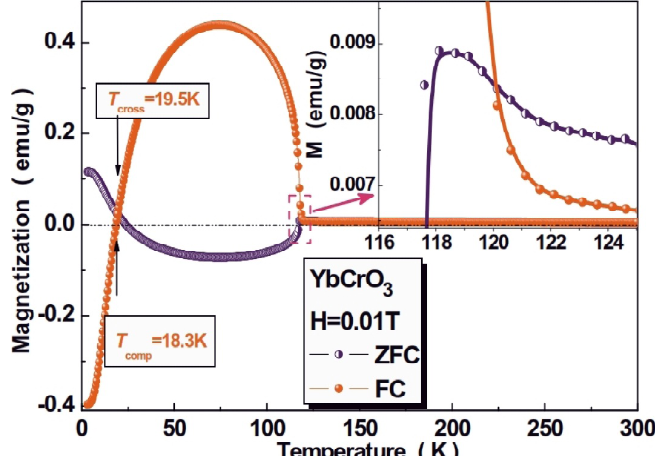
Fig. 1. ZFC and FC temperature dependent magnetization curve for YbCrO ing part near T =120K. Reproduced from [5] with the permission of AIP